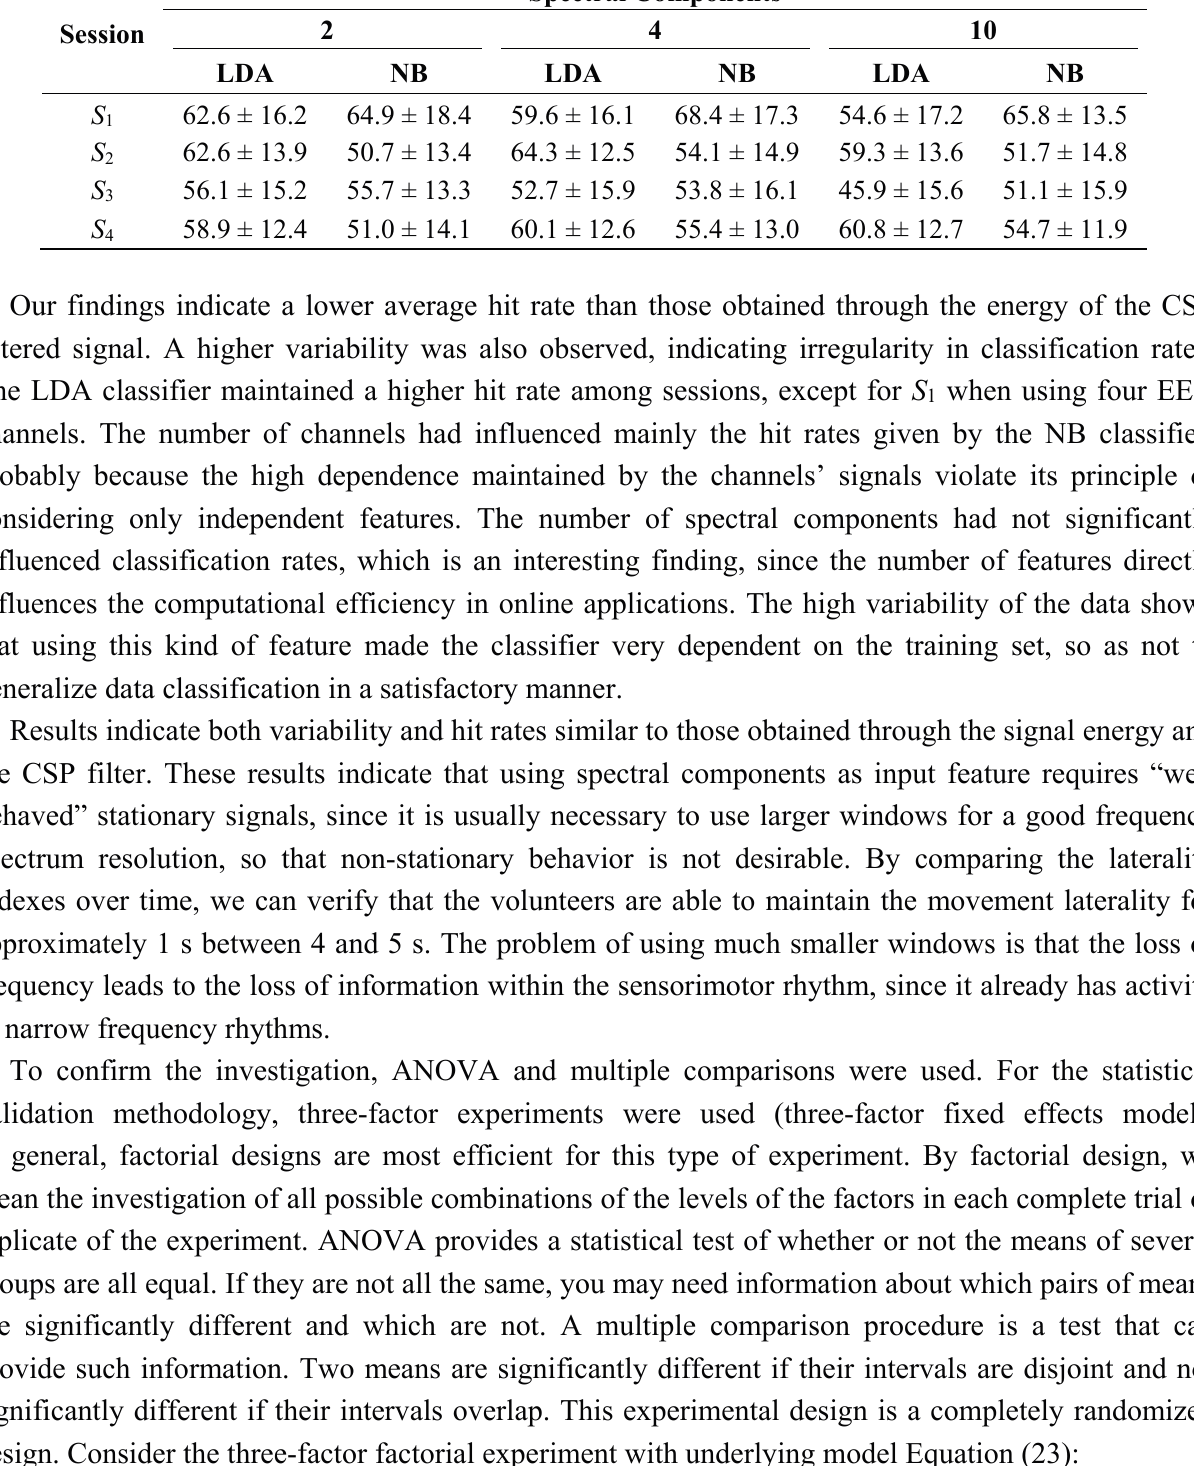
Table 6. Average hit rates using the spectral components of four channels (C3, C4, P3 and P4).